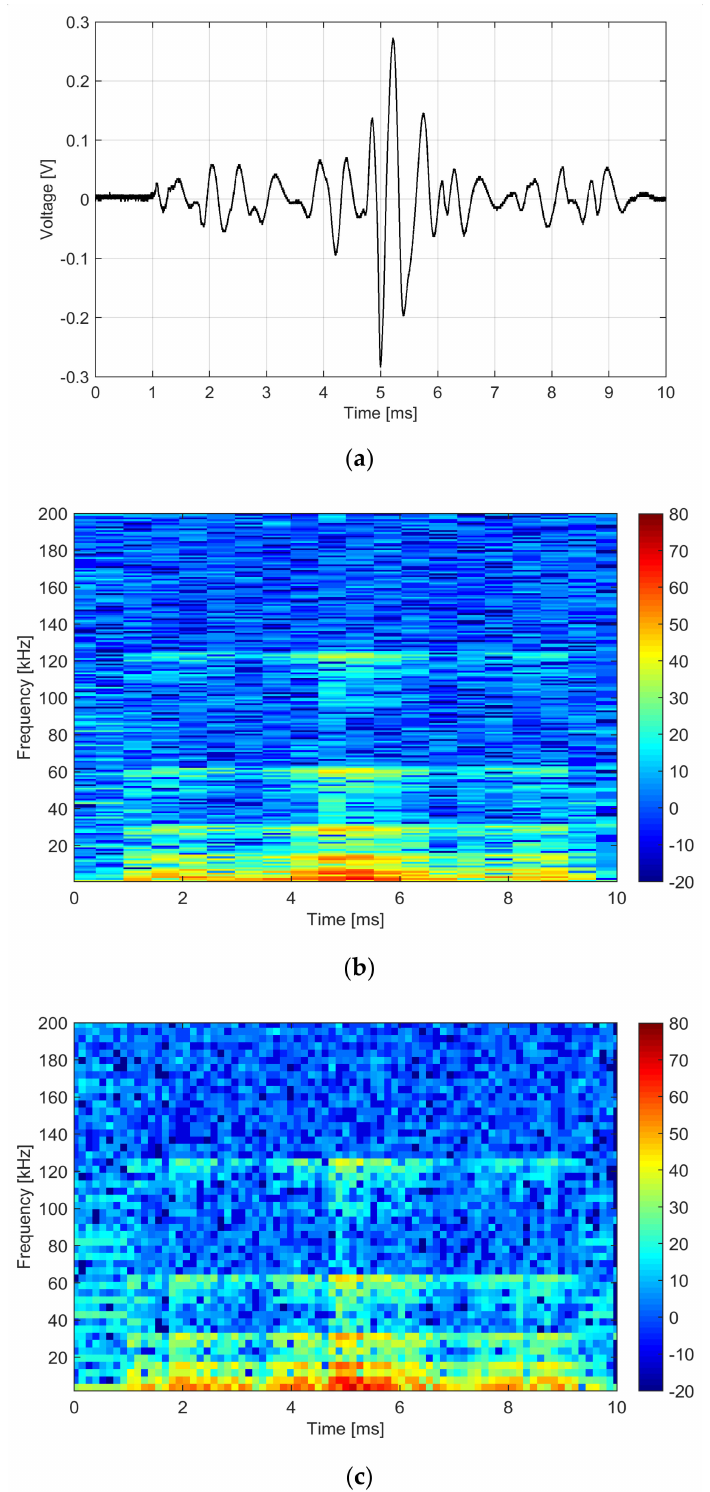
Figure 5. WPT spectrum in dB µ V / Hz (normalized by frequency resolution). An example of change of dilation in time and frequency by a factor of 4 with symlet1 wavelet: ( a ) signal waveform (10 MSa / s); ( b ) symlet1 with L = 9 levels and a downsampling of q = 10; and ( c ) symlet1 with L = 8 levels and q = 5. SMPS type Black at 25% of rated